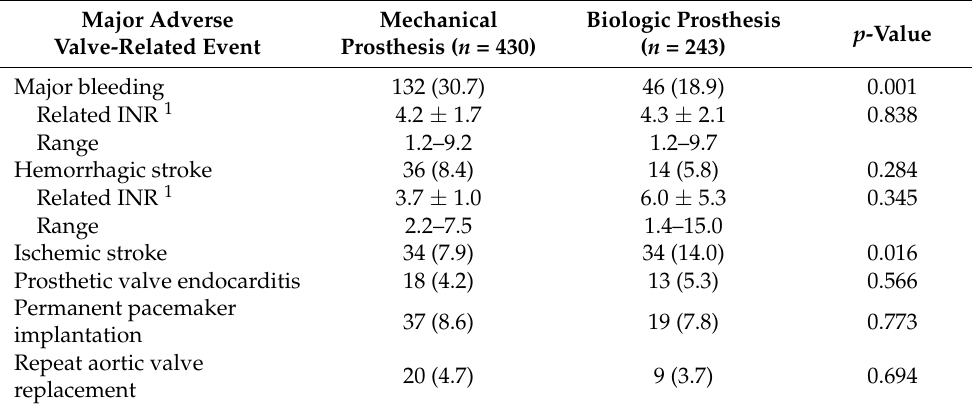
Table 10. Major adverse valve-related events during long-term follow-up.